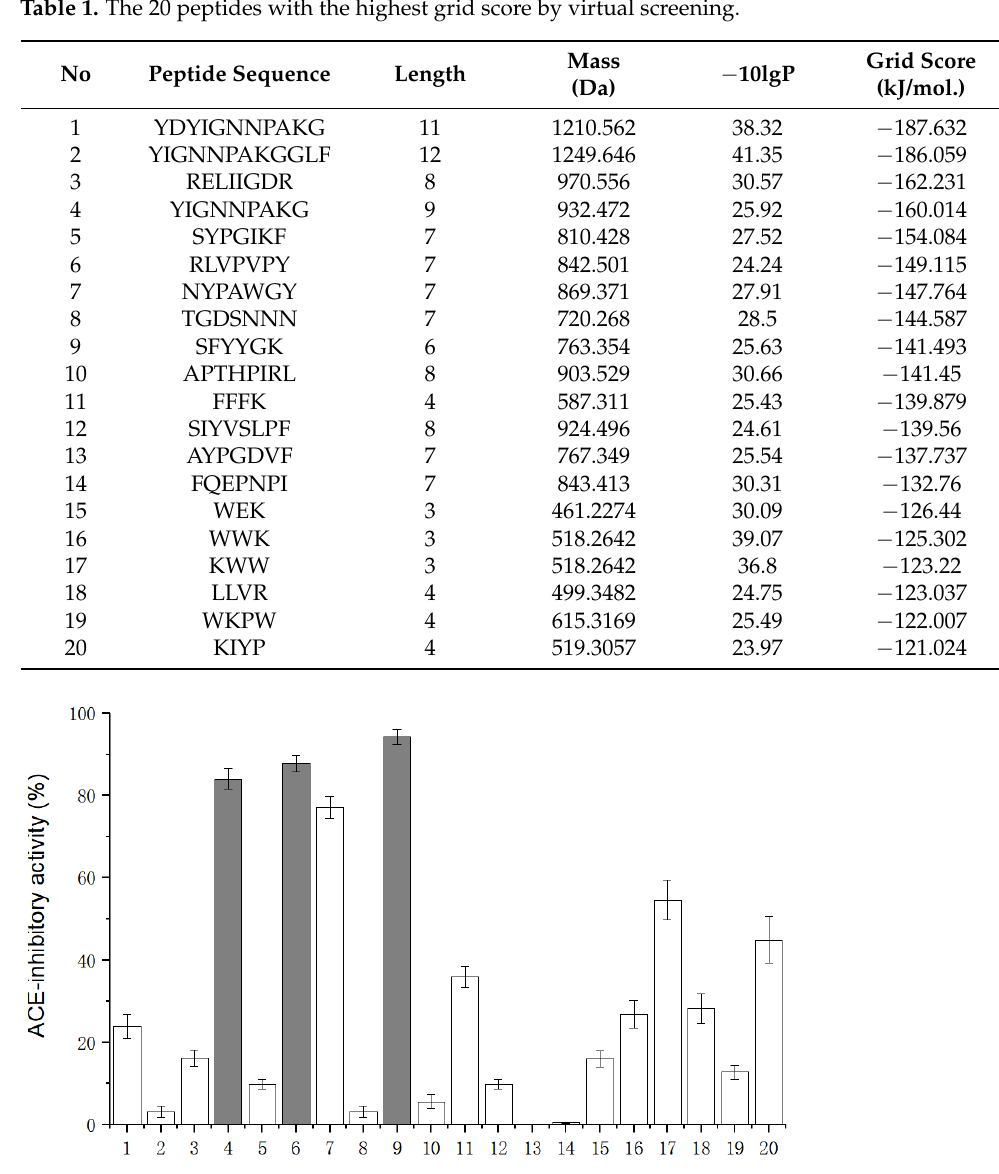
Figure 3. The ACE-inhibitory activity of synthetic peptides. The numbers represent the candidate peptides whose sequences are shown in Table 1.